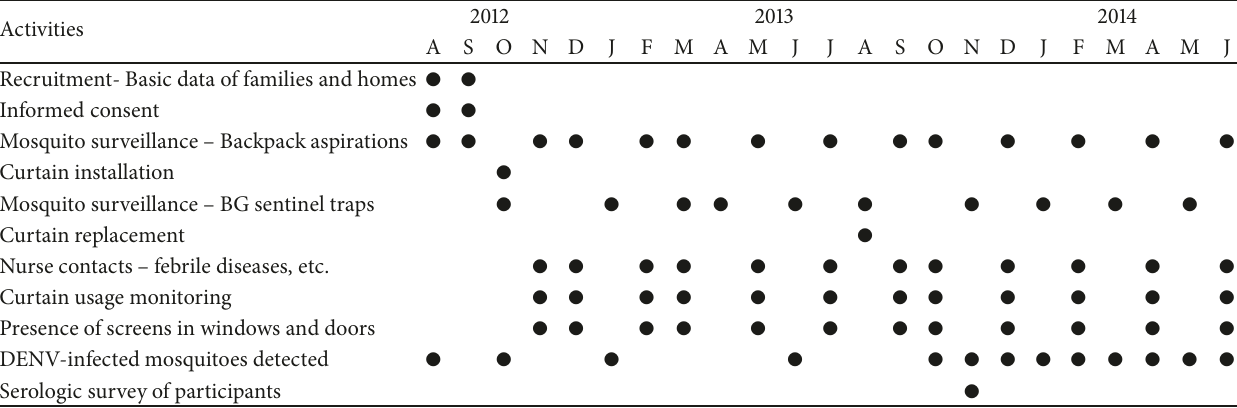
Table 1: Study schema: timeline of activities for the